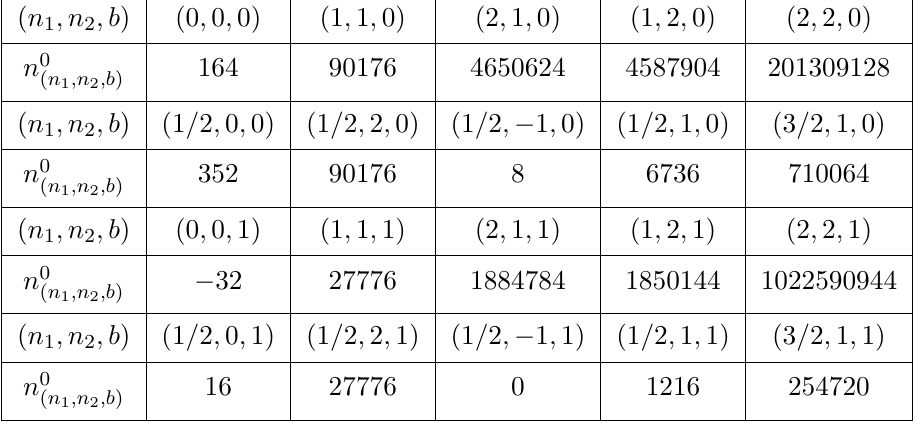
Table 7 . 2 A orbifold, non-standard embedding, with single Wilson line. Shift is given by, (cid:13)